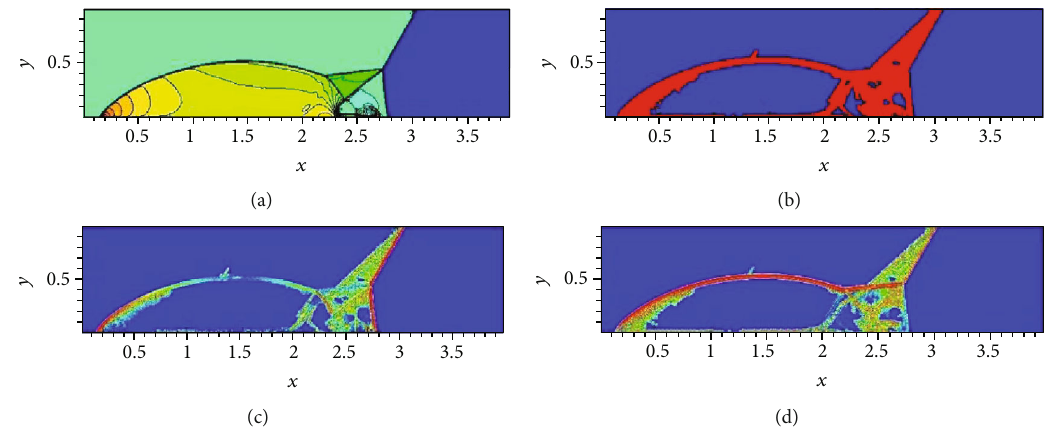
= 0 : 9 . DOFs = 1200 × 300 . Density from 1.5 to 21.7 with 30 contours. (a) Density contours from Figure 15: Results of the hybrid scheme. δ NI 1.5 to 21.7 with 30 contours. (b) Distribution of di ff erent cells: the red area represents WCNS cells, and the blue area represents CPR cells. (c) Distribution of NI in the x direction. (d) Distribution of NI in the y Table 4: CPU time comparison on solving the double Mach re fl ection problem.